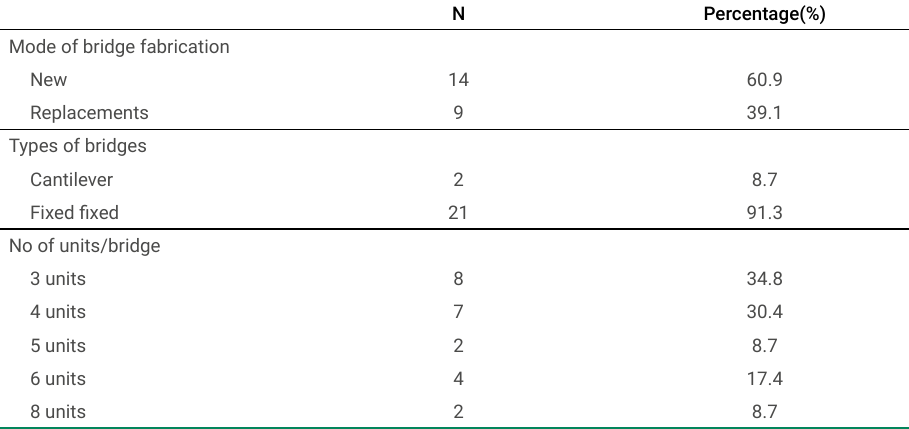
Table 4. Distribution of bridges